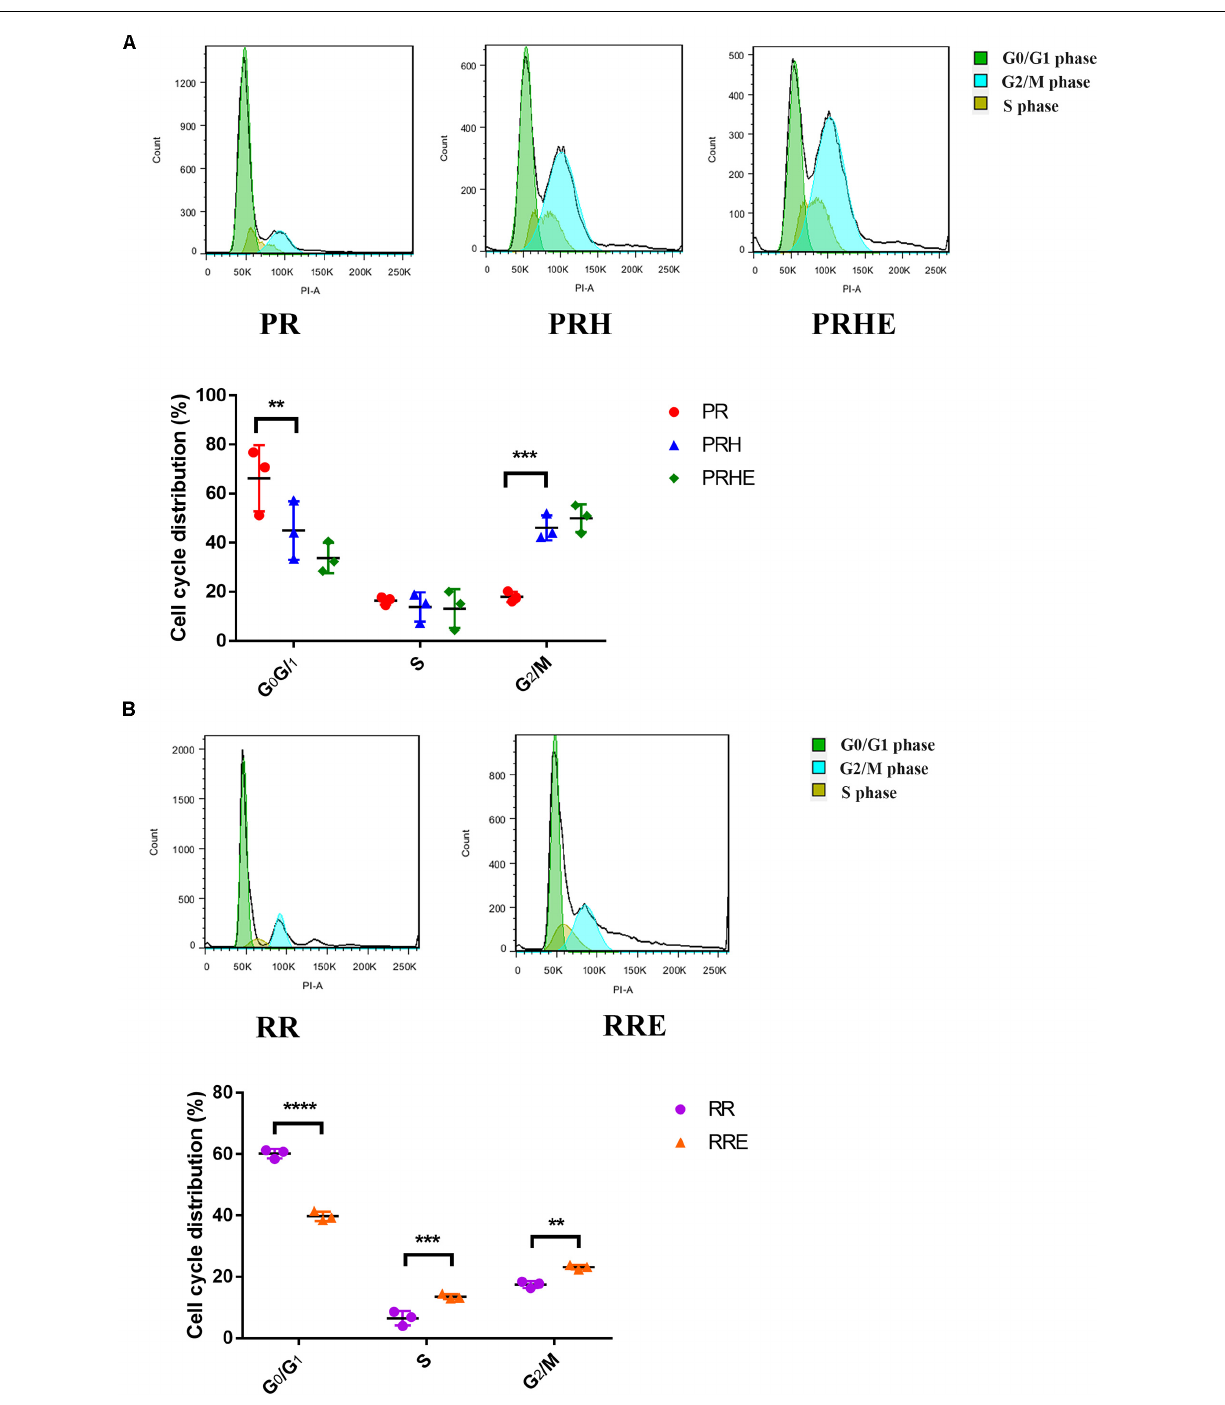
MMP (517.8 ± 20.03, p = 0.003) ( Figure 5I ) in the PRHE group were decreased compared with those in the PRH group. In the replicative senescence model, the levels of ROS (3108 ± 673.8,